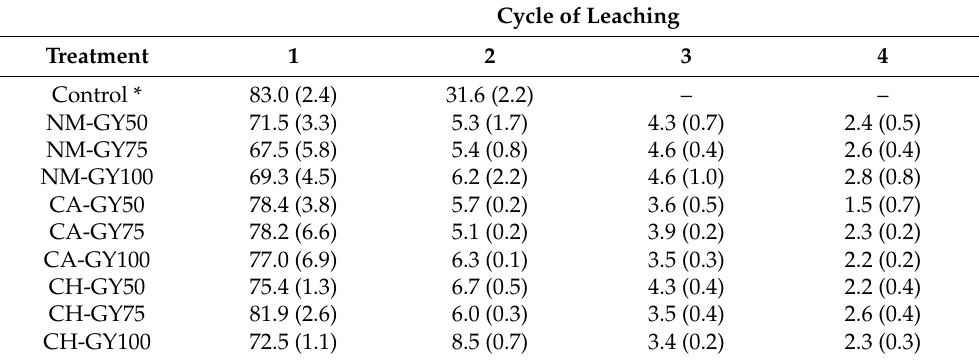
Table A2. Evolution of soluble salts as EC (dS m − 1 ) in the leachates at each cycle of leaching (pore